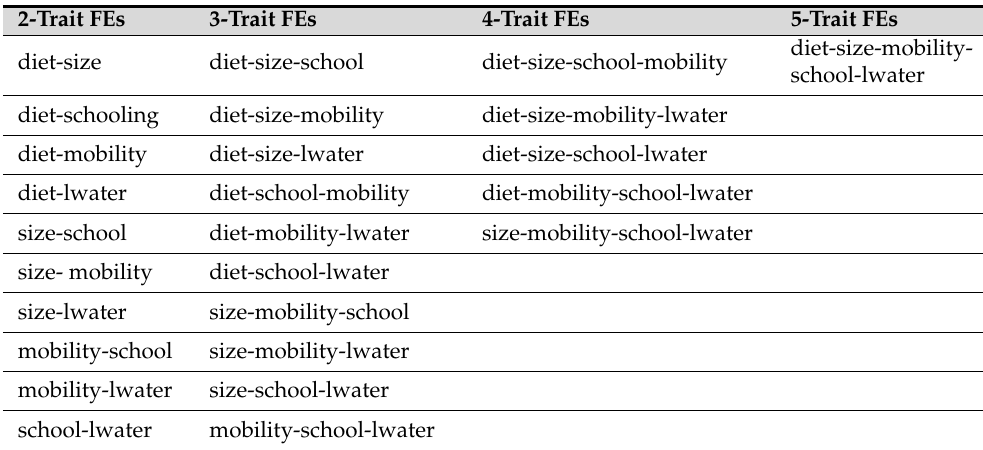
Table 2. Composition of the 26 types of FEs considered in the